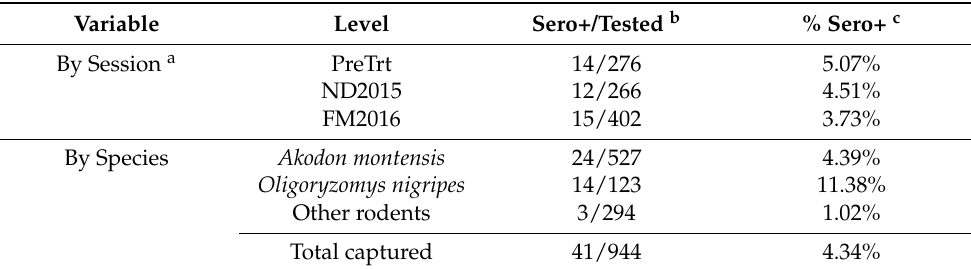
Table 2. Percentage of rodents seropositive (“Sero+”) for antibodies to hantavirus by immunofluores- cence assay during study by session and by species. Variable Level Sero+/Tested b % Sero+ c By Session a PreTrt 14/276 5.07% ND2015 12/266 4.51% FM2016 15/402 3.73% By Species Akodon montensis 24/527 4.39% Oligoryzomys nigripes 14/123 Other rodents